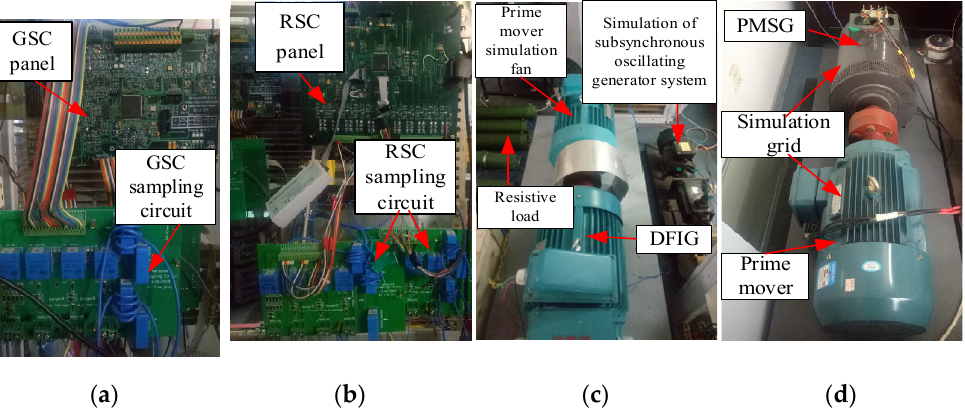
Figure 14. Experimental platform for the oscillatory inhibition of the DFIG system: ( a ) GSC experiment platform; ( b ) RSC experiment platform; ( c ) DFIG power generation device; ( d ) simulation power grid platform.